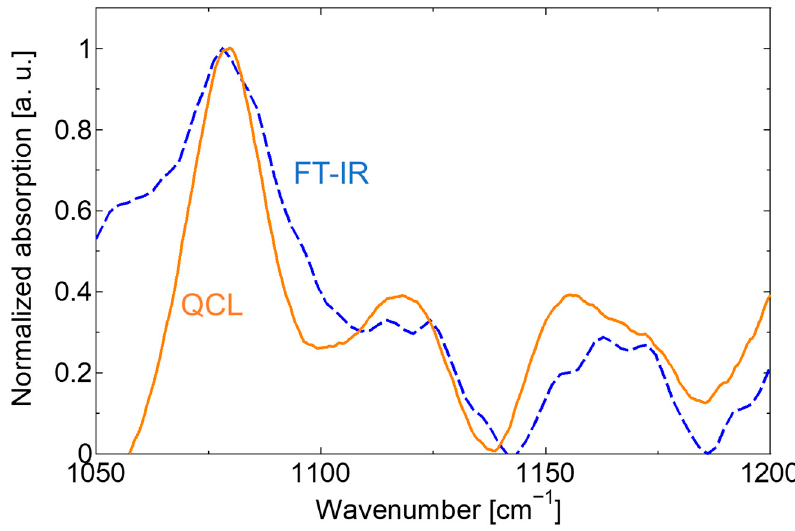
Figure 9. The absorption spectra of the lip mucosa.